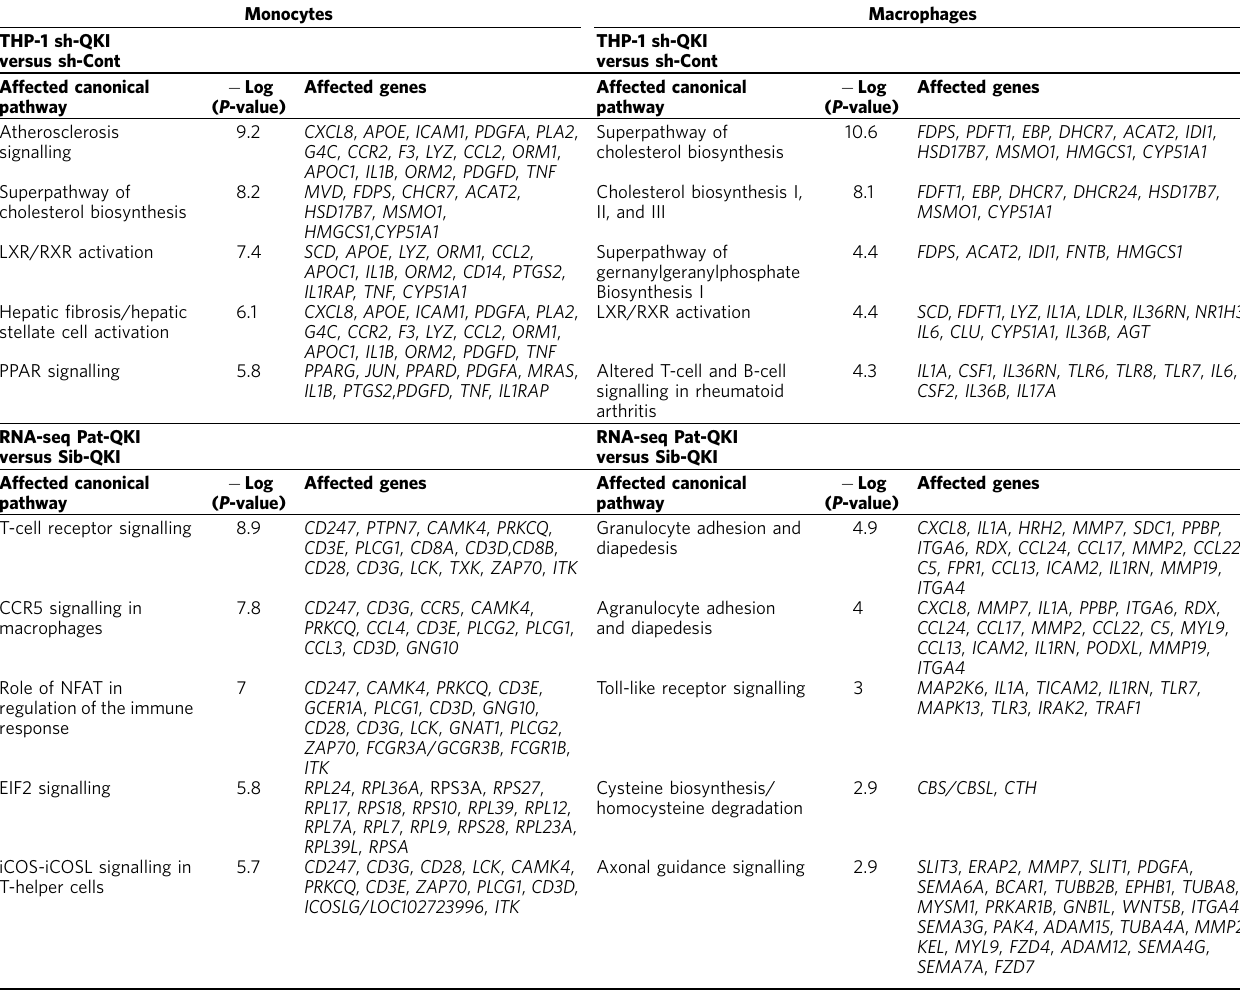
Table 1 | IPA assessment of pre-defined canonical pathways affected by changes in QKI expression. Monocytes